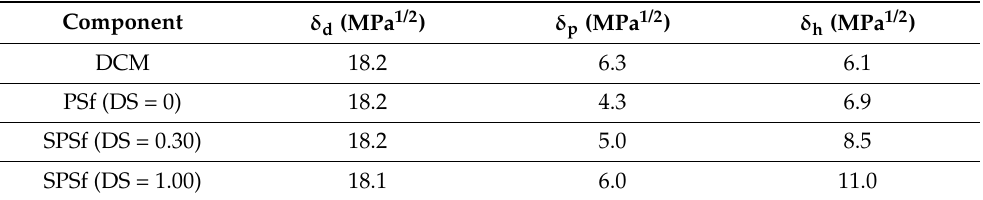
Table 2. Hansen Solubility Parameters of DCM, PSf, and SPSf [31,32].